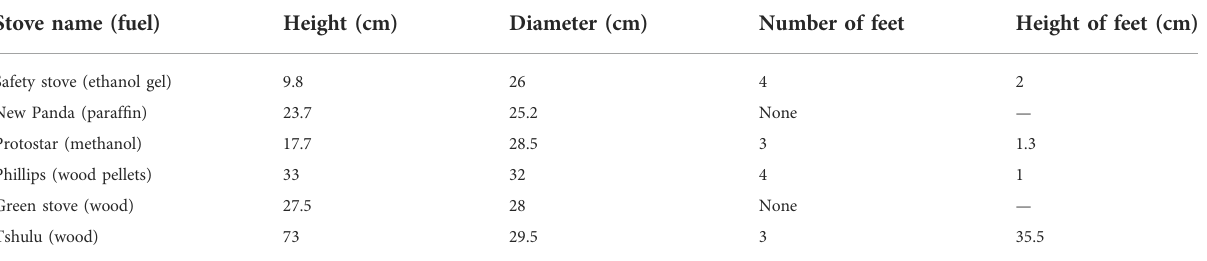
TABLE 1 Dimensions of the South African stoves.